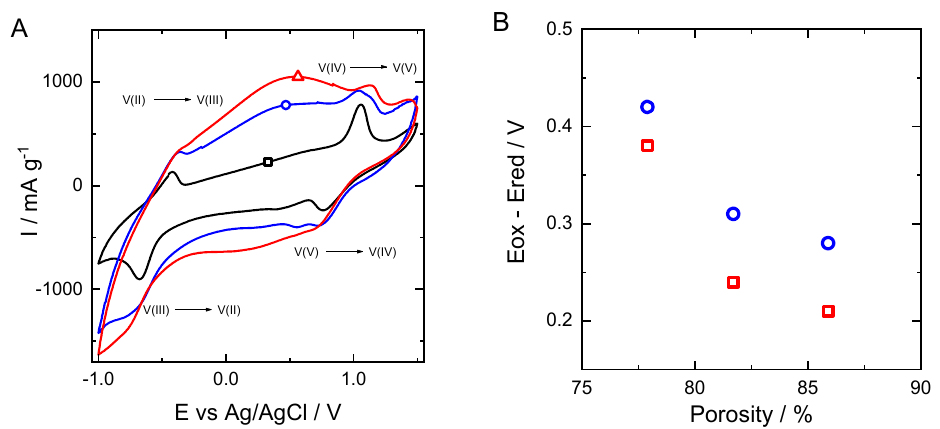
Figure 7. ( A ) Cyclic voltammograms recorded at 5 mV·s − 1 in 0.15 M V(III)/V(IV) solution prepared in 3 M H 2 SO 4 for samples SucNaCl0.80 ( □ ), SucNaCl1.00 ( ○ ) and SucNaCl1.25 ( △ ). ( B ) Differences between oxidation and reduction potential as a function of porosity: V(V)/V(IV) ( ○ ) and V(III)/V(II) ( □ ).